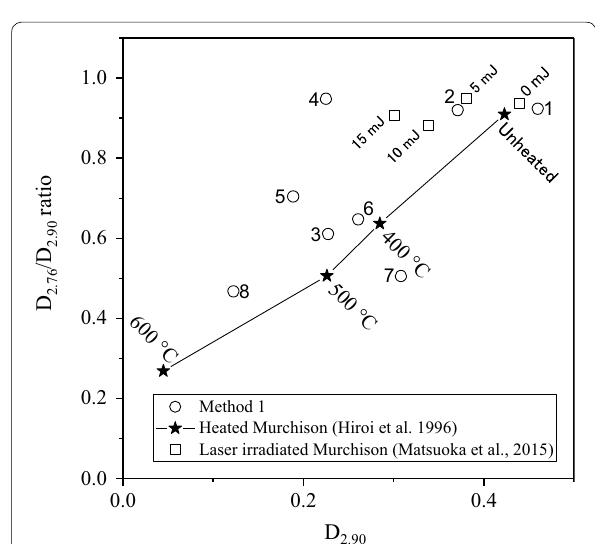
Fig. 12 D 2.90 values and the D 2.76 / D 2.90 ratios of NIRS3 data of the meteorite samples corrected by the method 1, plotted with those of FT-IR spectra of Murchison samples heated in vacuum (up to 600 °C, Hiroi et al. 1996) and irradiated by pulse laser (Matsuoka et al. 2015). Labels: 1 Murchison, 2 Murray, 3 Y-793321, 4 Jbilet Win- = = = = selwan, 5 Y 982086, 6 Y 980115, 7 Y-86720, and 8 = = = =